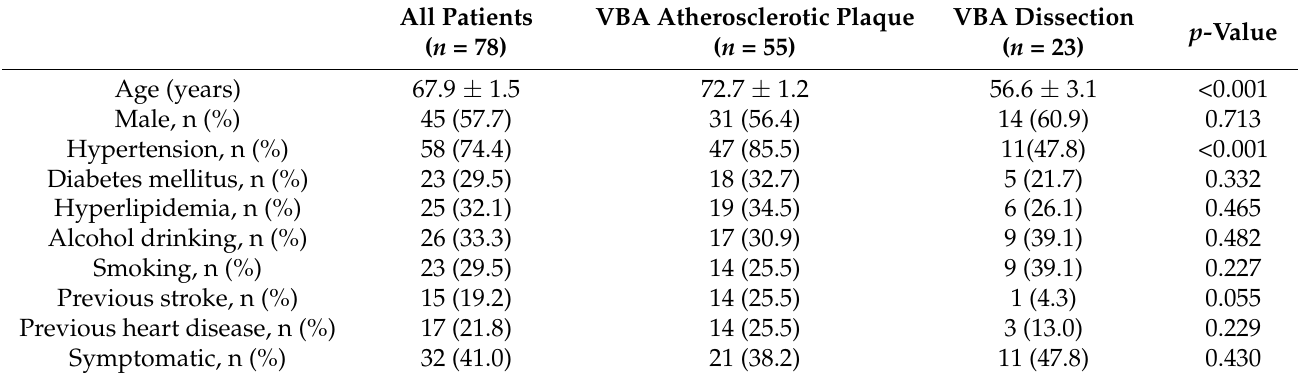
Table 1. Baseline characteristics between VBA IPH and VBA